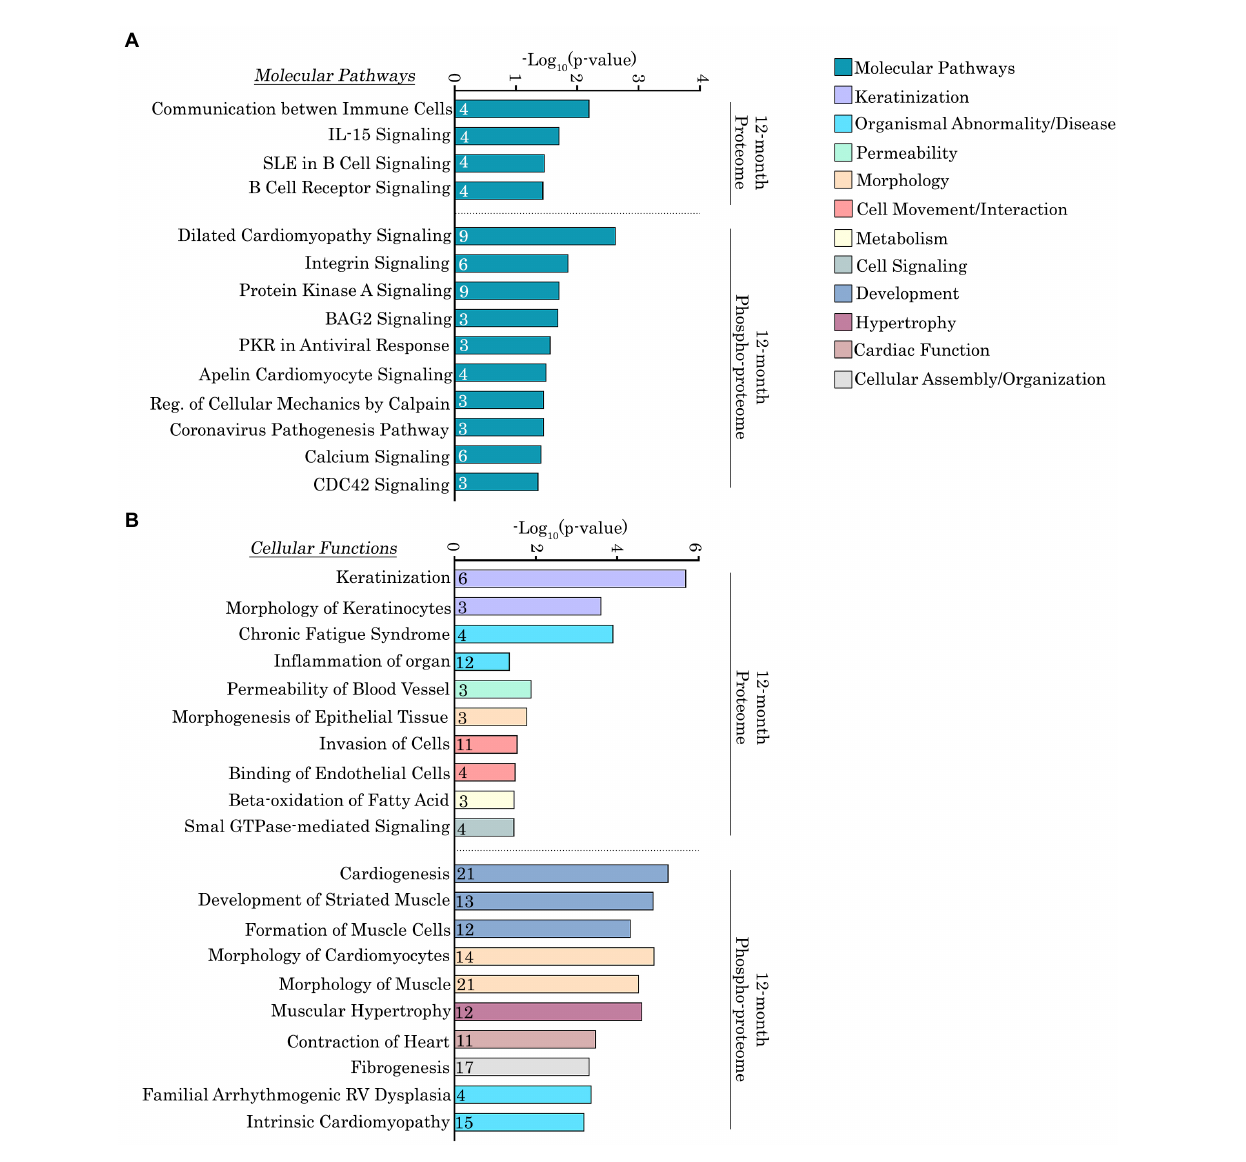
FIGURE 7 Ingenuity pathway analysis of the deregulated proteins and phospho-proteins in Obscn- Δ Ig58/59 atria at 12-months. (A,B) The molecular pathways (A) and cellular functions (B) associated with proteins that exhibited significantly altered expression or phosphorylation in 12-month-old Obscn- Δ Ig58/59 atria. The number of proteins associated with each biological process is indicated within the respective